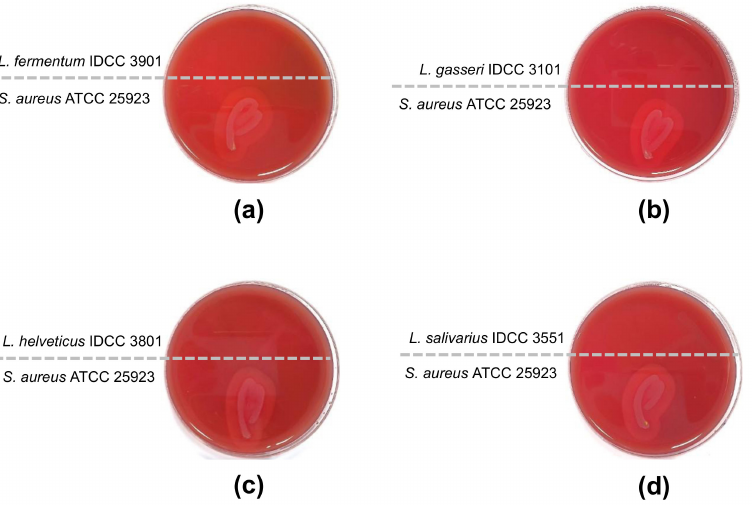
Figure 1. Test for β -hemolytic activity. S. aureus subsp. aureus ATCC 25923 was used for a positive control and showed β -hemolytic activity. ( a ) L. fermentum IDCC 3901; ( b ) L. gasseri IDCC